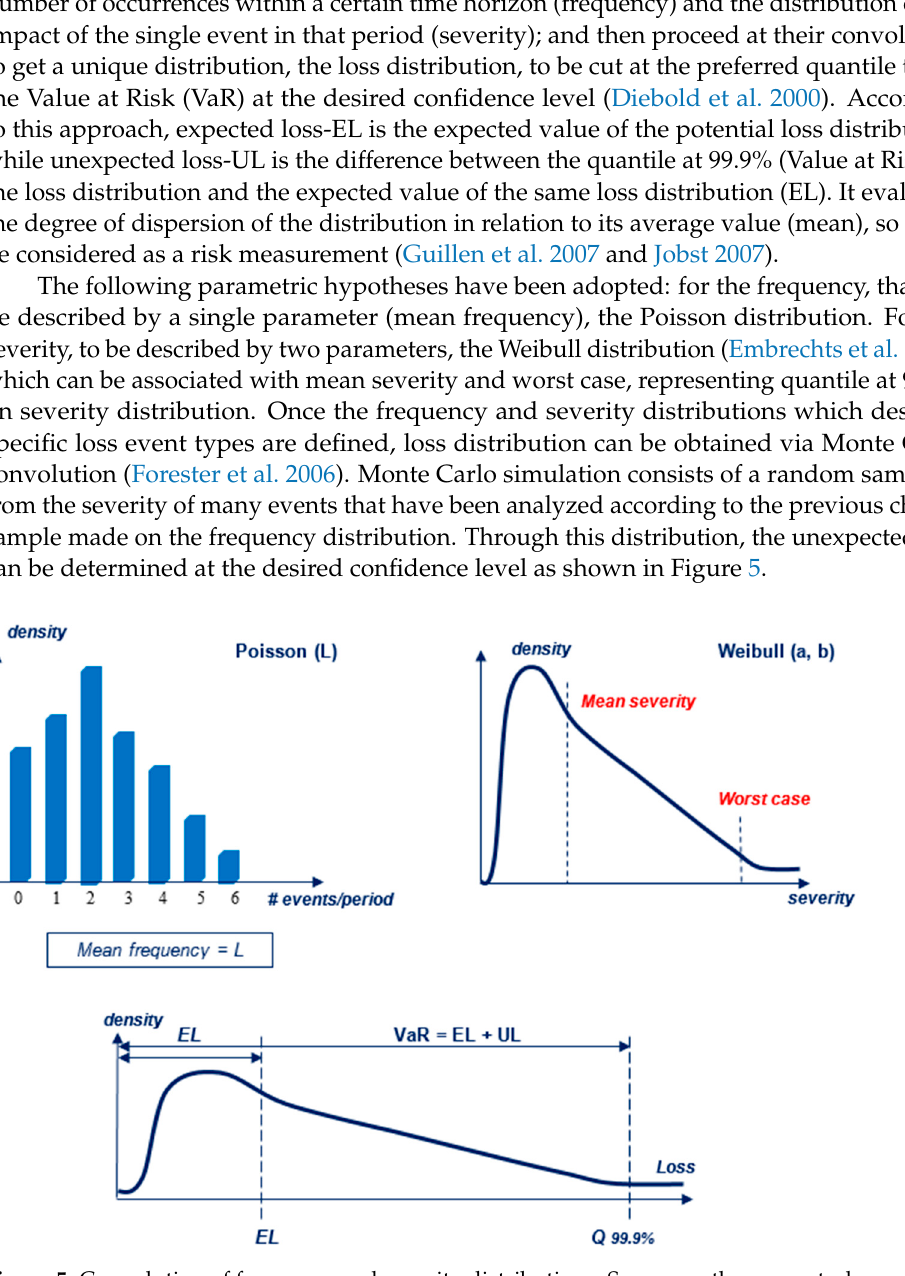
Figure 5. Convolution of frequency and severity distributions. Source: author own study.